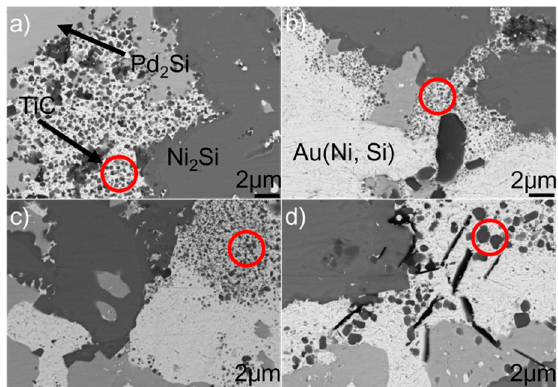
Figure 7. BSE images showing the braze seam obtained for 10 min at ( a ) 1423 K, ( b ) 1473 K, ( c ) 1523 K, and ( d ) 1573 K.